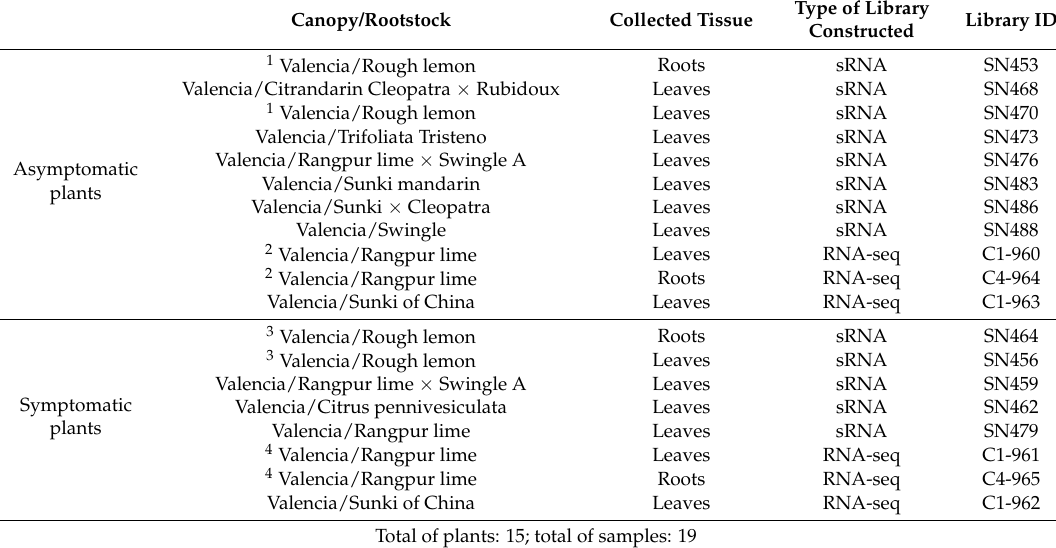
Table 1. Citrus plants used to assess the viral sequences by using high-throughput sequencing. All experimental plants had Citrus sinensis cv. Valencia scions that were grafted onto different rootstocks. Rootstock varieties, type of collected plant tissue and type of library constructed are